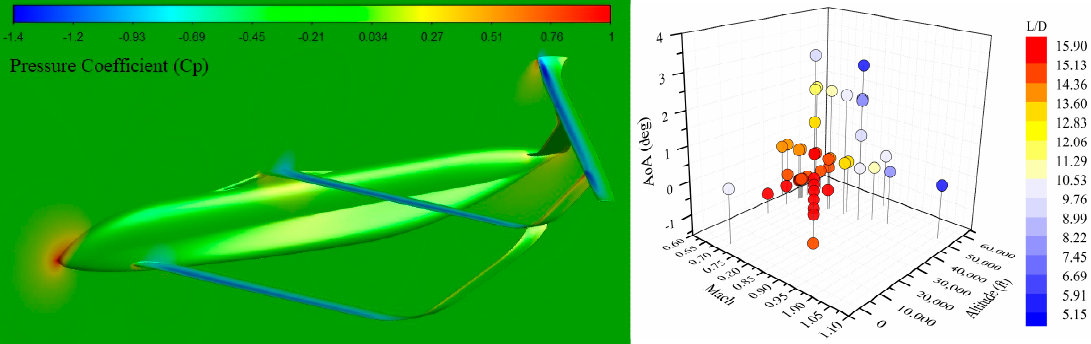
Figure 14. BWA/SL aircraft in various flight conditions. ( Left ): Steady pressure (C p coefficient) on and around the aircraft in cruise flight condition S 3 (M = 0.7 at 43,000 ft) with an angle-of-attack α = 0 ◦ . ( Right ): L/D values obtained for the various flight conditions and aerodynamic settings ( α